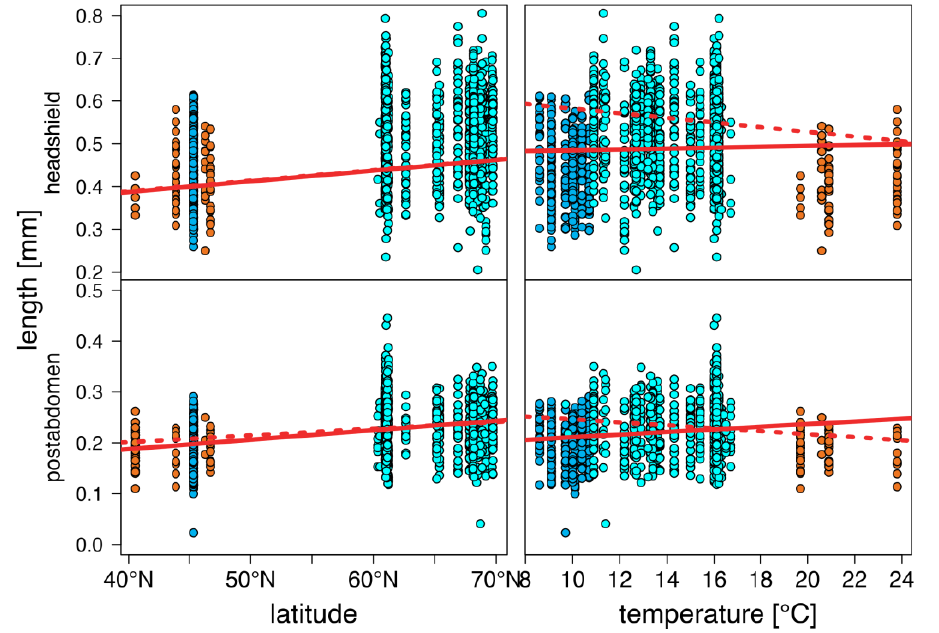
Figure 4. Relationship between latitude (left panel), temperature (right panel) and length of headshield and postabdomen of Alona affinis ( warm lakes, Southern mountain lakes, Finnish lakes, solid line: all-lake model, dashed line: omit-SM model; Table A3).